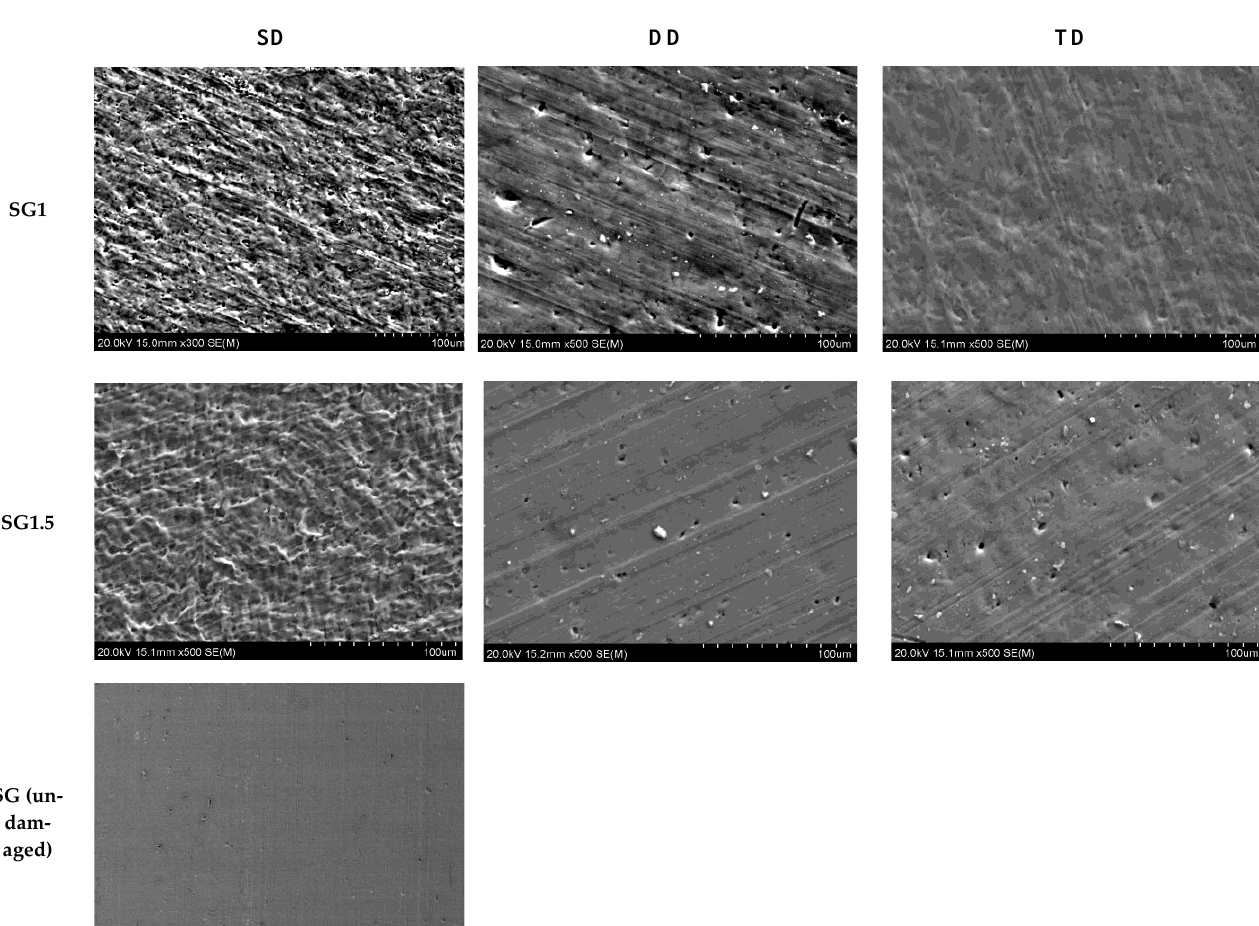
Figure 5. SEM images of the coatings after and before 36 min cavitation test.